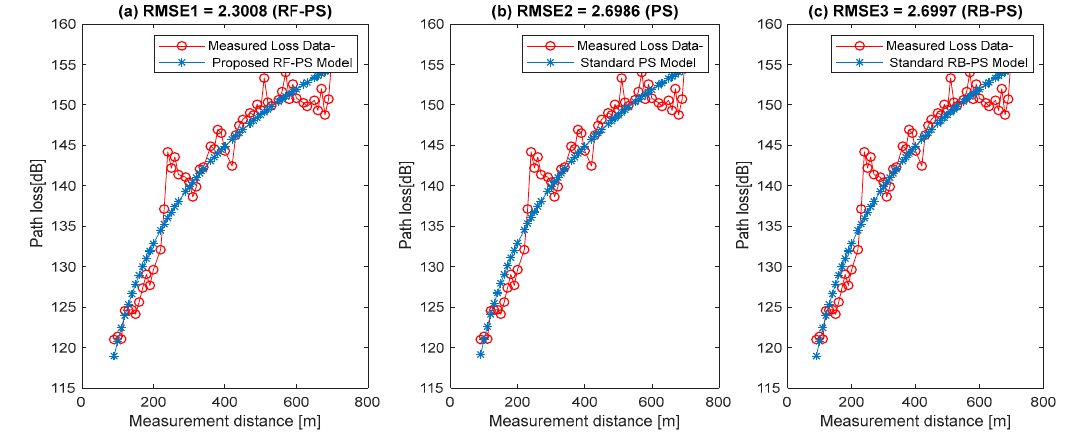
Figure 11. Results showing the measured path loss versus distance using the hybrid RF-PS method and two existing standard path loss prediction methods in site 1 of location 2.